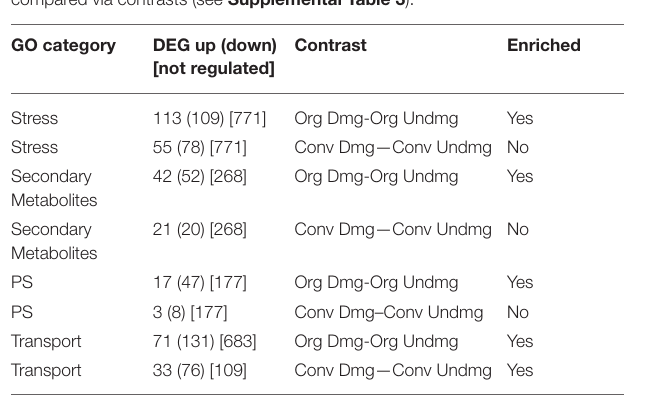
Frontiers in Sustainable Food Systems |